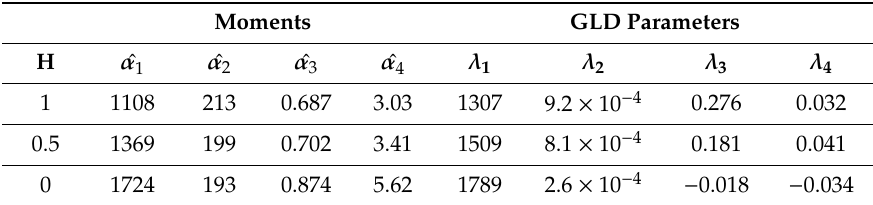
Table 1. Values of the fourth moments and the generalized Lambda distribution (GLD) parameters for the three pressure corresponding to the Hurst exponent of H = 0, 0.5 and 1 (Figure 3).